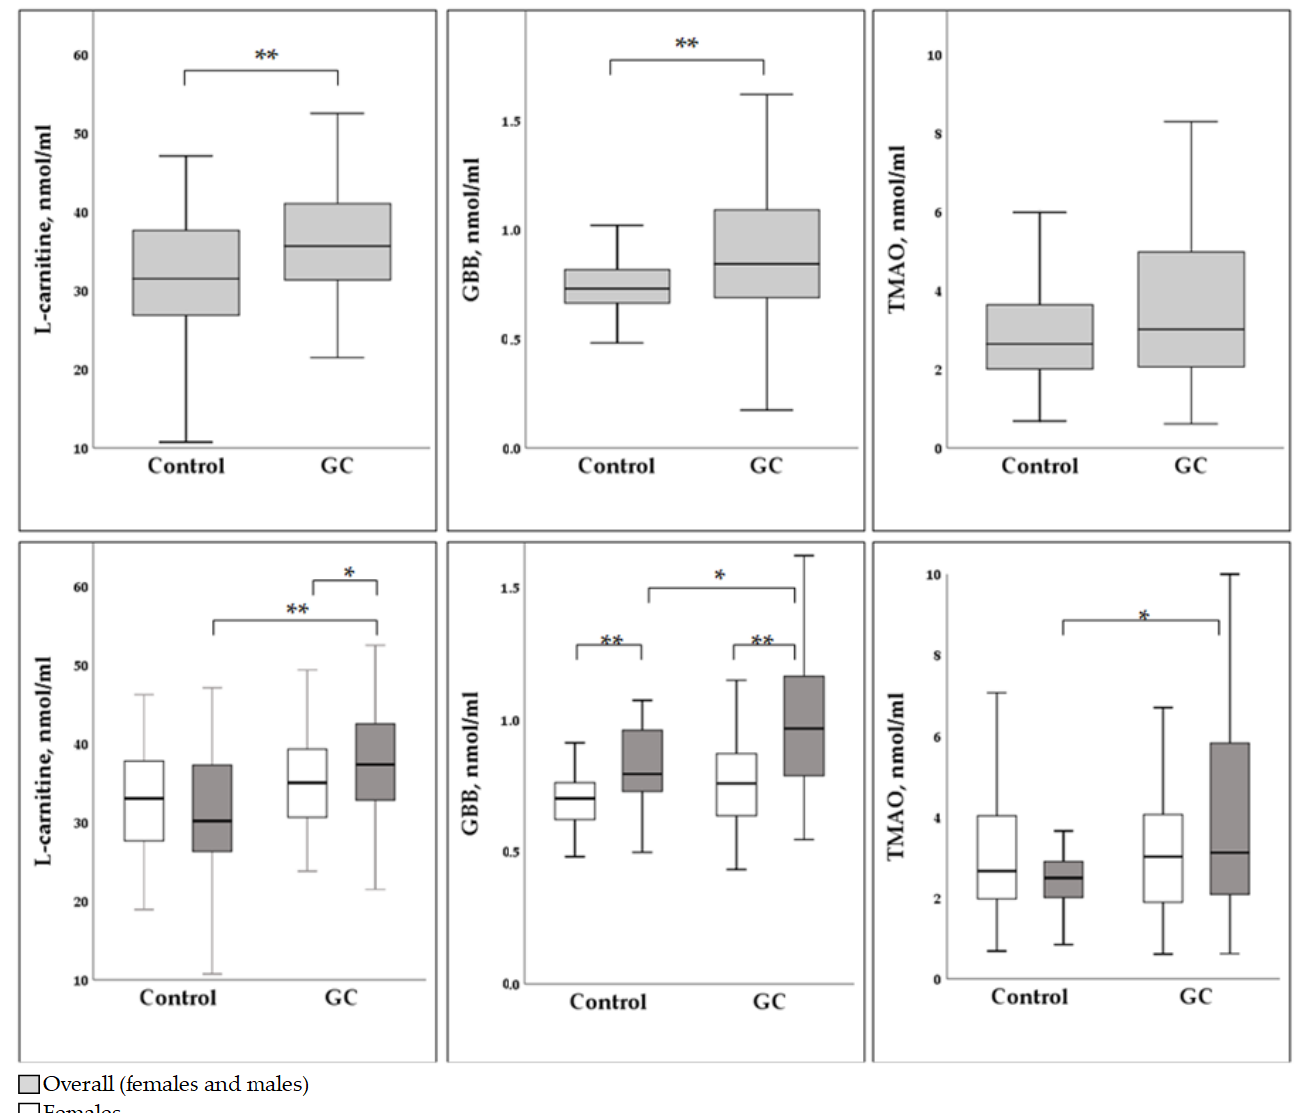
Figure 1. Serum concentrations of L-carnitine, GBB and TMAO in the control group and the gastric cancer group. ( Upper row )—median concentrations in an overall group. ( Lower row )—median concentrations in female and male groups. GBB— γ -butyrobetaine; TMAO—trimethylamine N-oxide levels; GC—gastric cnacer; * p < 0.05; ** p < 0.001.